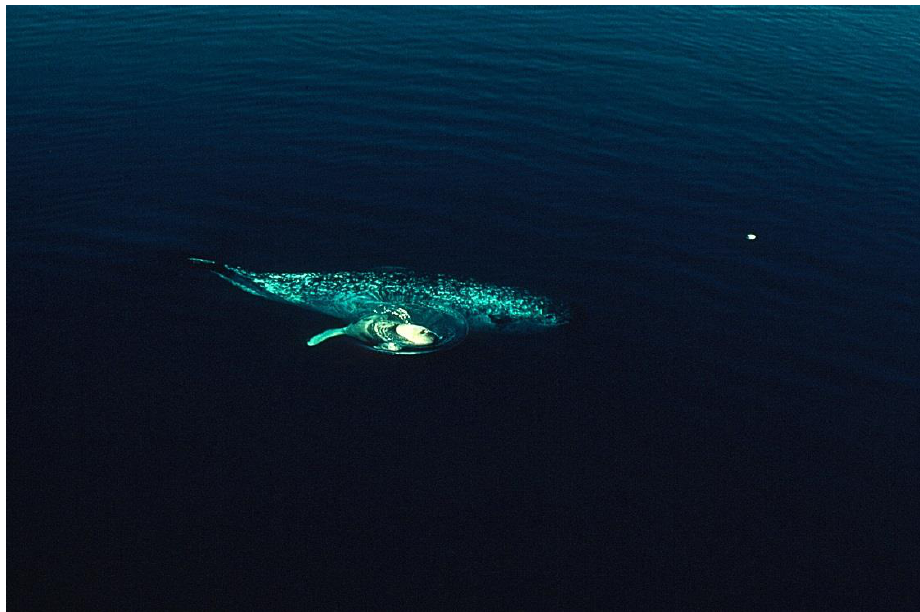
Fig. 1: Narwhal and calf. (Photo: R. E. A. Stewart) The narwhal has embedded teeth that never erupt except for the canines. Male narwhals are characterised by the long straight helical tusk evolved from the upper left canine tooth while the right canine is also spiralled but is short